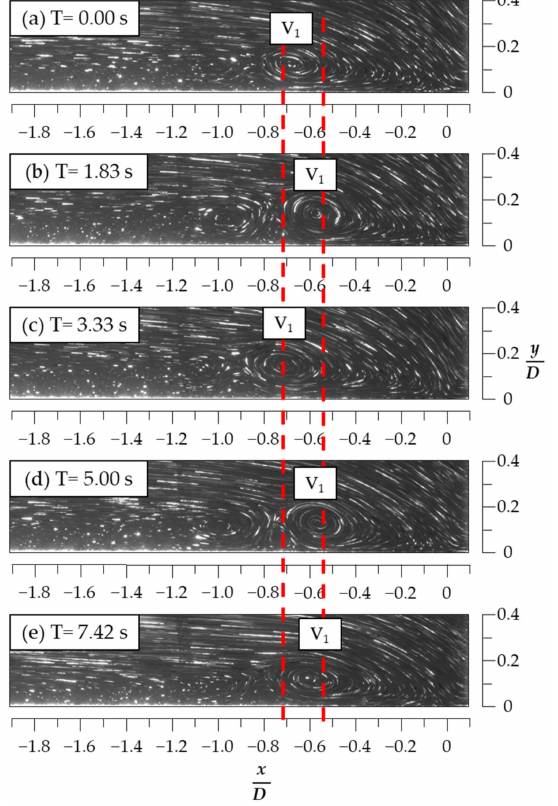
Figure 9. Time-series flow visualization of the HSV’s kinematic mode: “oscillation with a small displacement” in the z = 0.4 cm plane when H / D = 1.5. The two red dashed lines indicate the oscillation range of the core of the HSV closest to the LE (labeled V 1 ) between x / D = − 0.56 and −